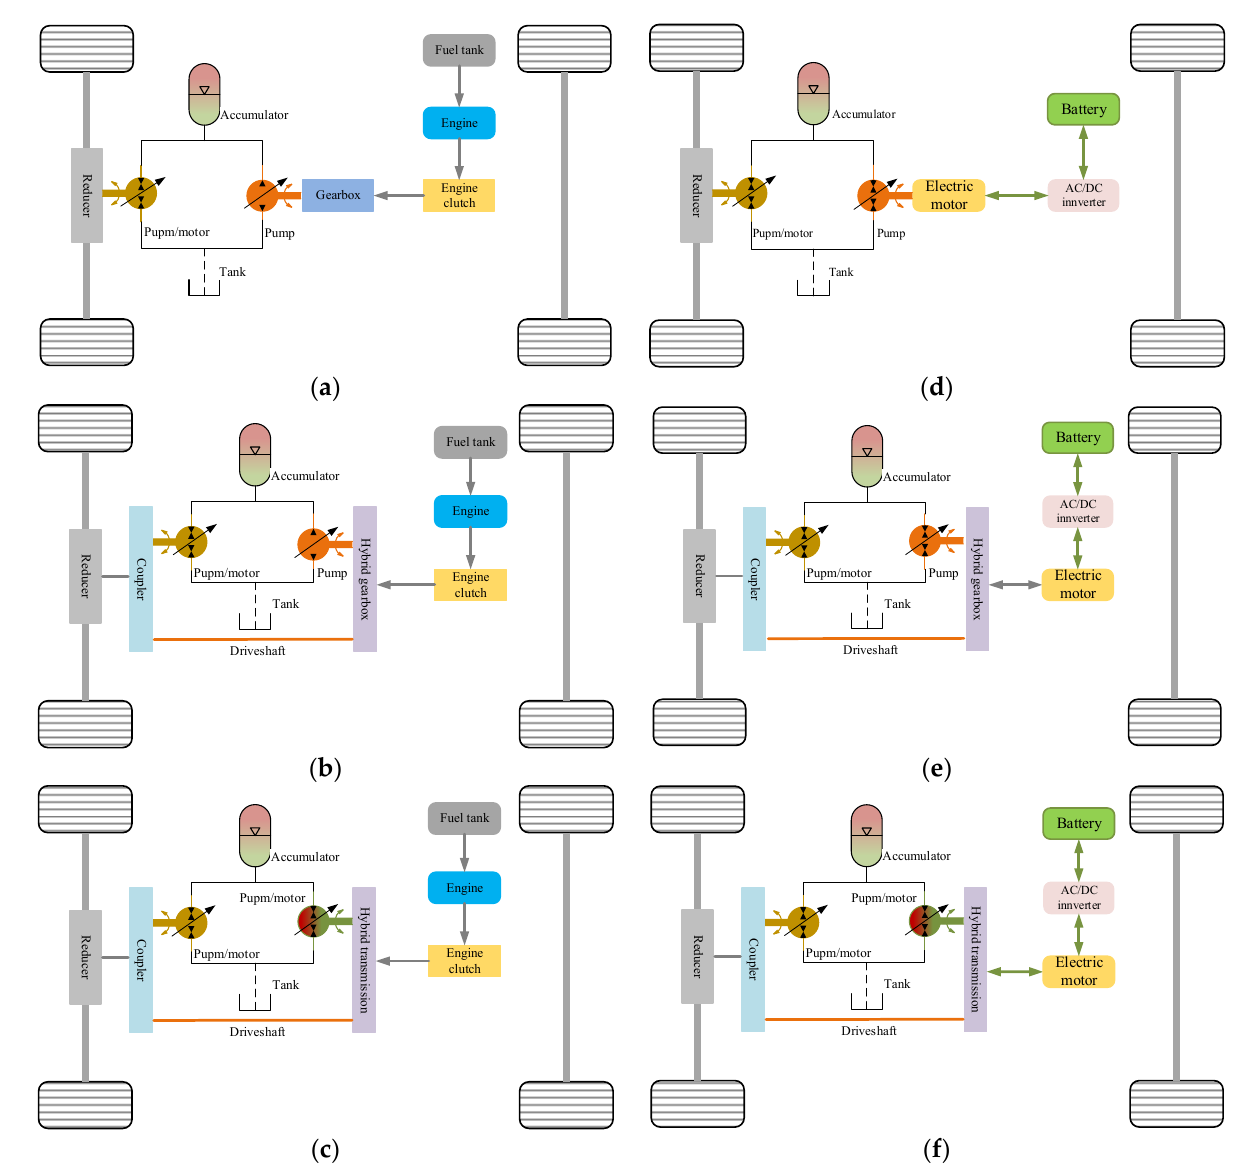
Figure 4. Diagrams of energy flow in previously typical developed series ( a , d ), parallel ( b , e ), and series–parallel ( c , f ) hydraulic hybrid vehicles [53,64–68].